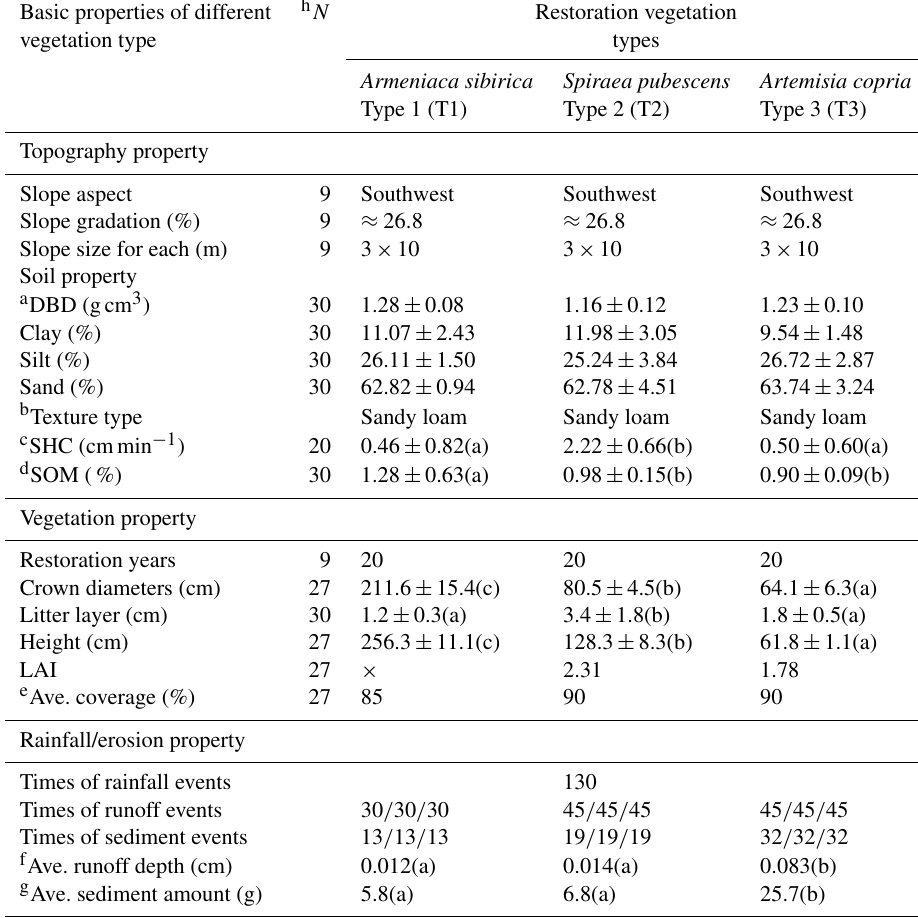
Table 4. Basic properties of soil, vegetation and erosion in different restoration vegetation types. Basic properties of different h